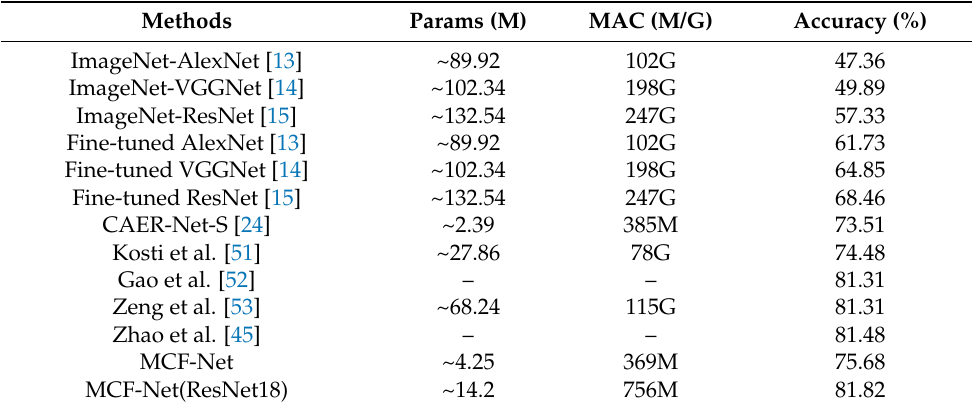
Table 1. Comparison results on CAER-S dataset.